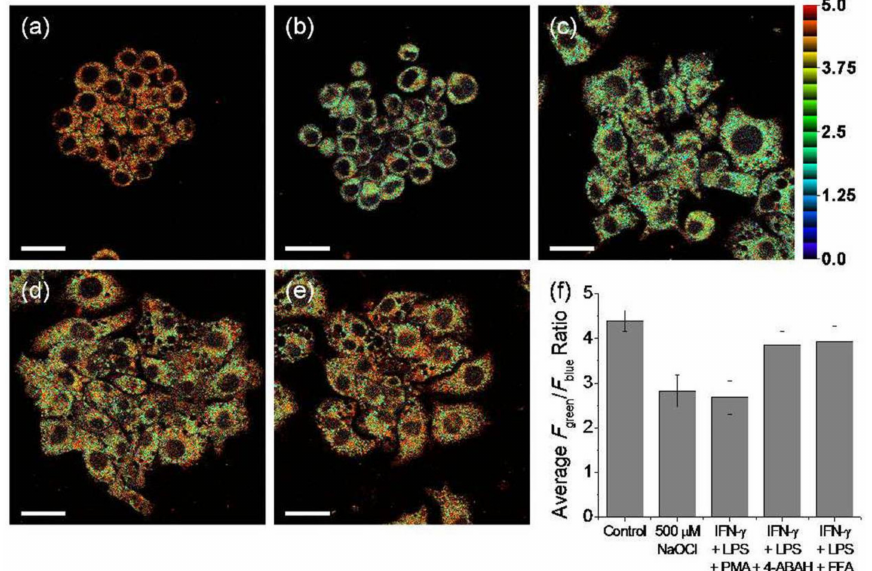
Figure 11. Pseudocolored ratiometric two-photon microscopic images of Raw 264.7 cells incubated with probe 4 (5 µ M) for 30 min. Cells were pretreated with ( a ) 0; ( b ) NaOCl (500 µ M, 30 min); ( c ) LPS (100 ng/mL, 16 h), IFN- γ (50 ng/mL, 4 h, PMA (10 nM, 30 min); ( d ) LPS, IFN- γ , PMA, and 4-ABAH (50 µ M, 4 h); and ( e ) LPS, IFN- γ , PMA, and FFA (50 µ M, 4 h) before treated with 7 . ( f ) Average F green / F blue ratios of the corresponding two-photon images. 730 nm excitation and 380–430 nm (blue) and 480–600 nm (green) emission windows. Scale bars = 25 µ m